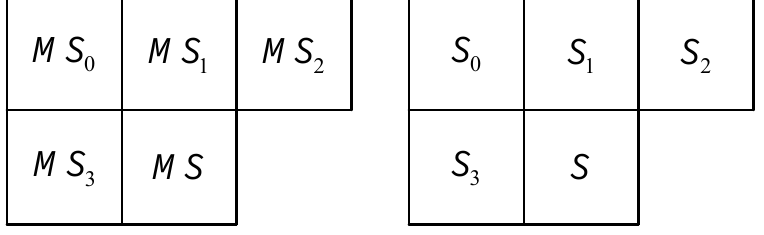
MS and signs S of already encoded data sam ‐ i i